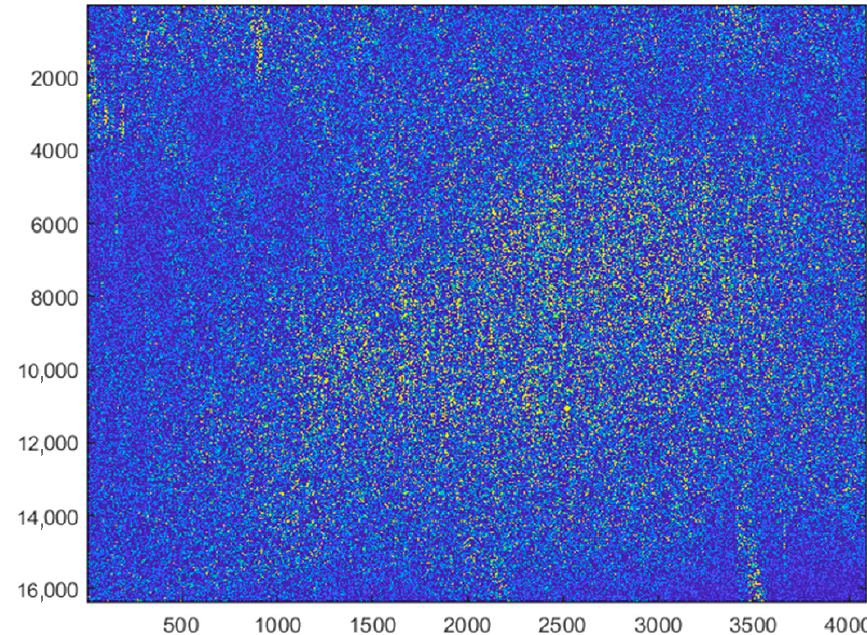
Figure 3. Radar data before processing (“raw” data)—the whole image.